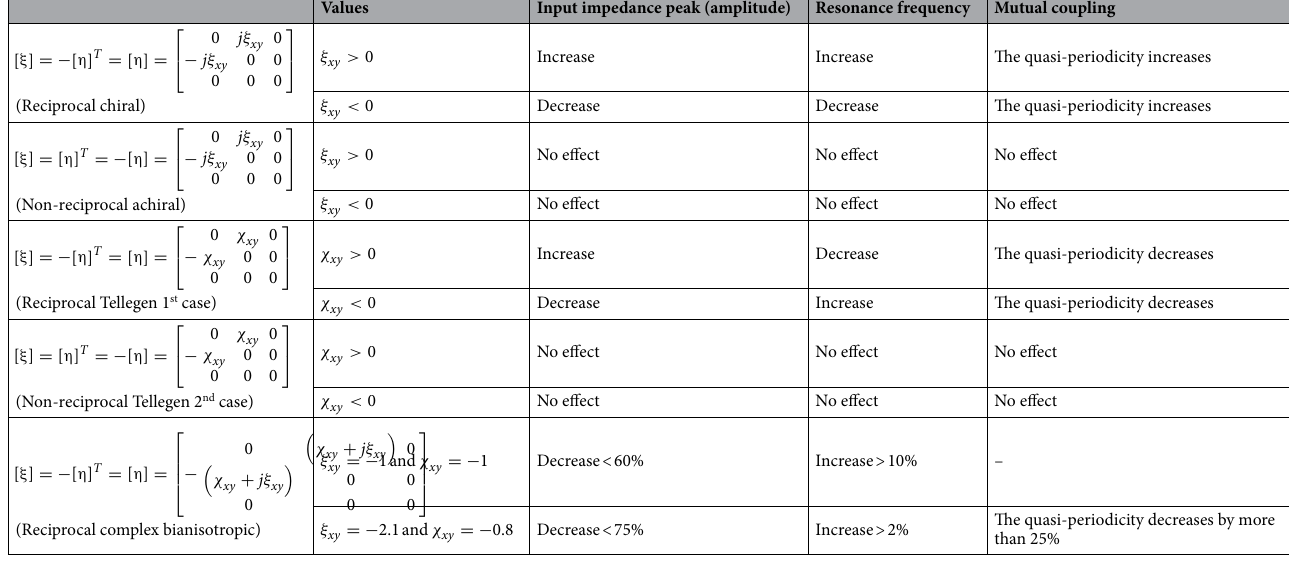
Table 1. Summary of the obtained